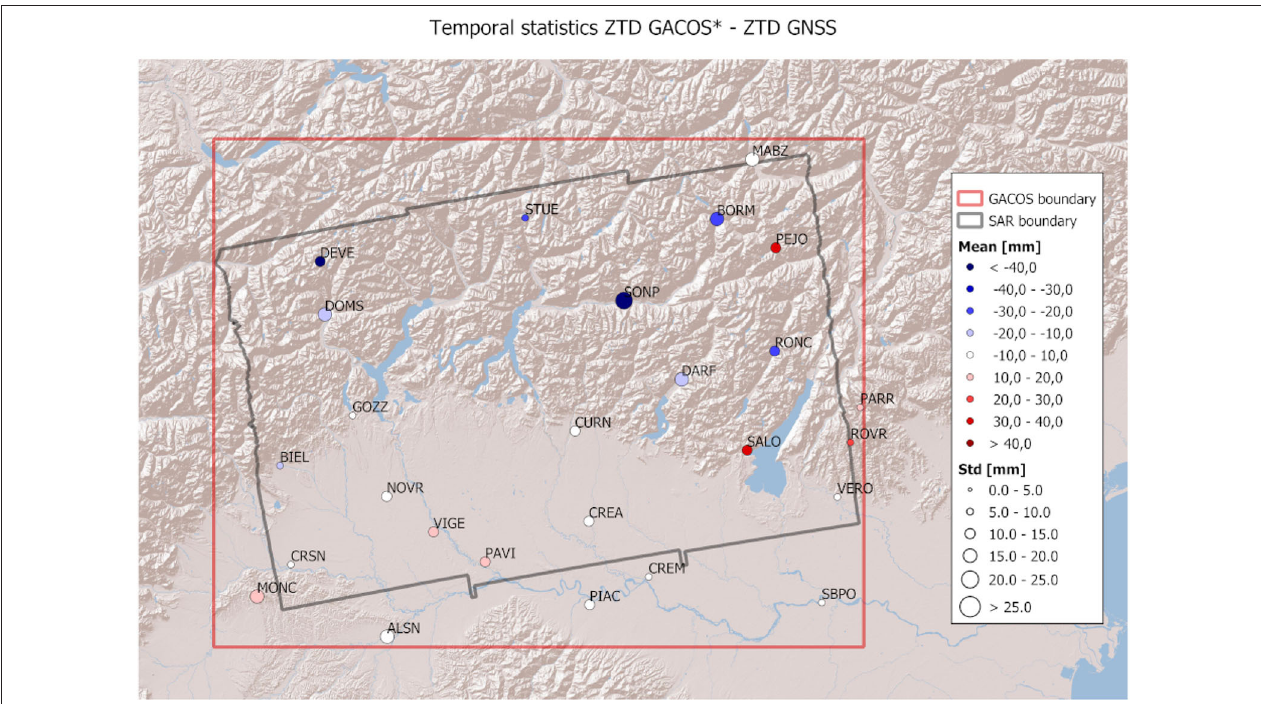
FIGURE 11 | Map of the temporal statistics of the difference between GACOS* ZTD and GNSS ZTD. Note that here, the statistics for GACOS are computed after undersampling it on the 3DVAR grid and only on the 14 dates where 3DVAR is available.